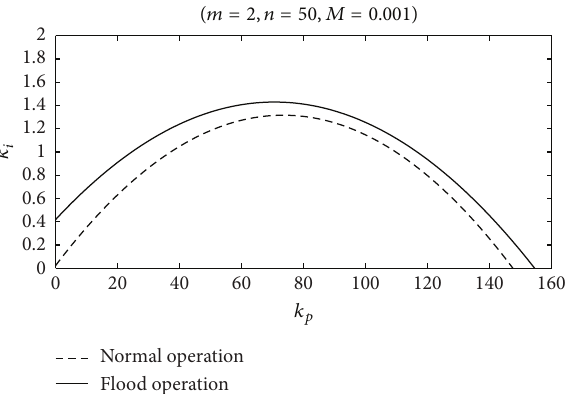
Figure6:Stabilityregions:effectofthesurfaceareaoftheheadpond